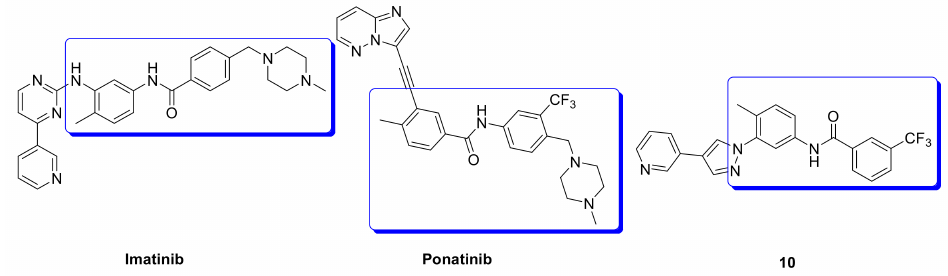
Figure 19. Structures of pyrazole-based BCR-ABL kinase inhibitors and their IC 50 values. Docking study of compound 10 into the Bcr-Abl crystal structure was performed to study its binding mode. The pyridine ring is the hinge region-binding moiety of this structure, similar to imatinib. The pyridyl nitrogen accepts a hydrogen bond from Met318. The amide linker forms two more hydrogen bonds with Glu286 and Asp381. Moreover, the pyrazole ring forms pi-pi stacking interaction with Thr315 (Figure 20) [21].